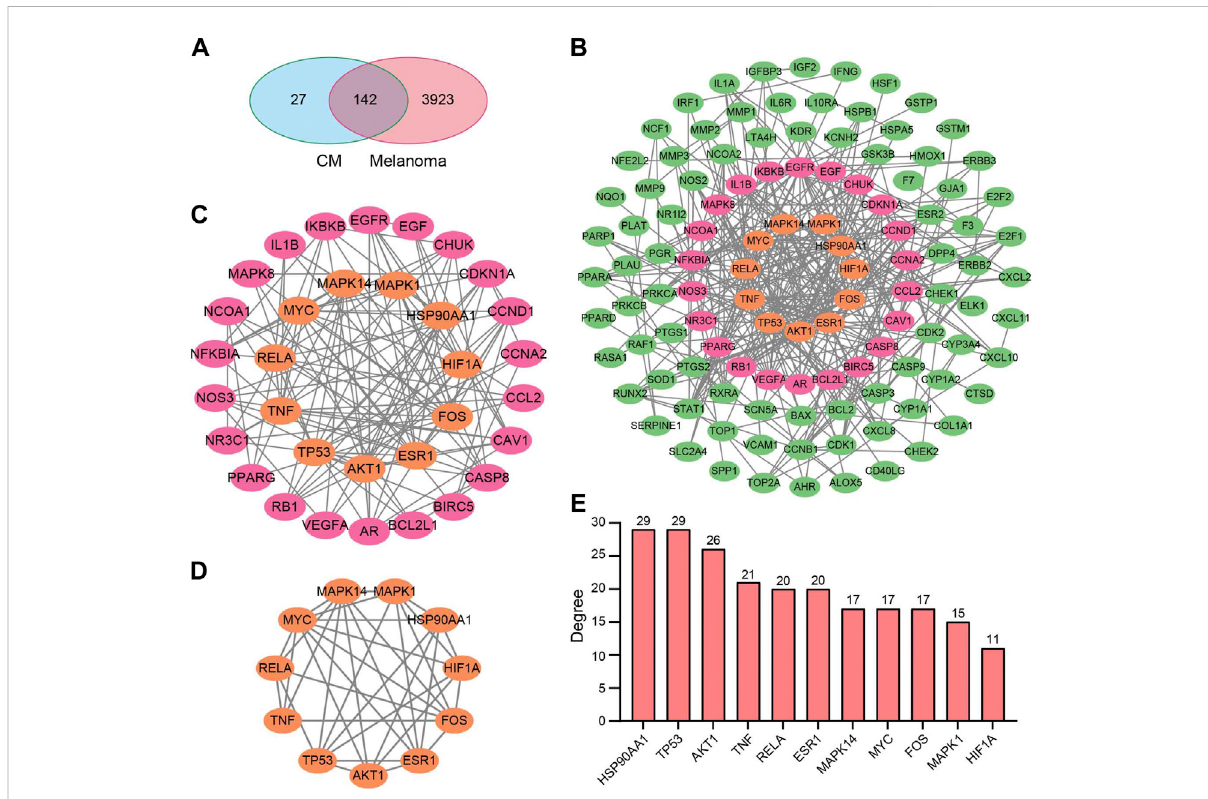
FIGURE 2 PotentialtargetgenesandPPInetworkmapofCMtreatmentformelanoma. (A)